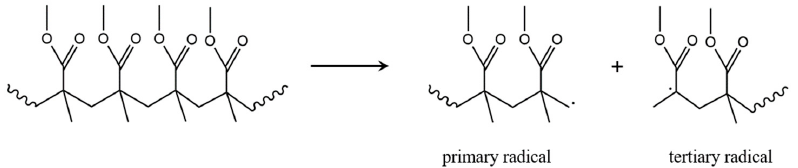
Figure 8. First thermal degradation initiation reaction by random fission of poly(methyl methacrylate) PMMA (so at head-tail structural characteristic formed during synthesis) with the formation of a primary and tertiary macroradical.